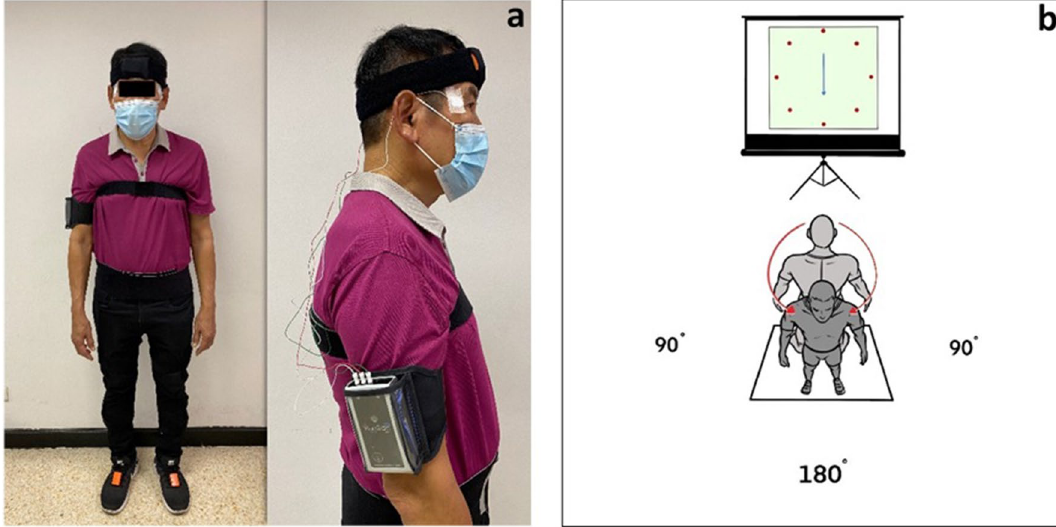
Figure 1. ( a ) Five inertial measurement units and electrooculography attachment, and ( b ) experimental setting